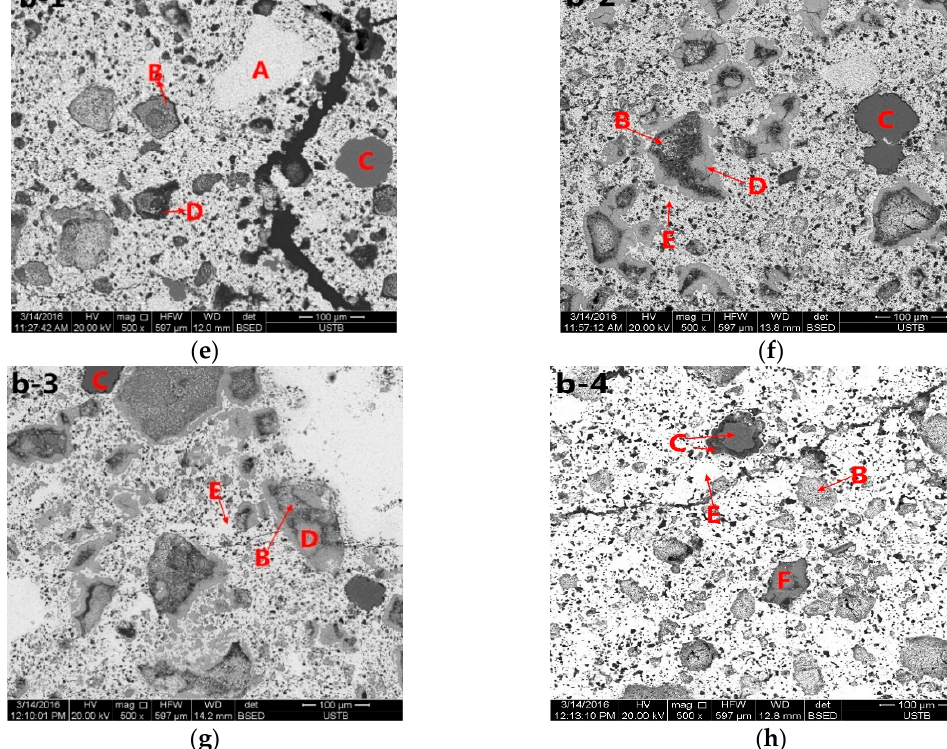
Figure 4. Backscattered electron micrograph of the product of the heat/quench experiment performed at different temperatures for 90 min under air atmosphere, showing Al 2 O 3 , Fe 2 O 3 , CaO, CF, C 2 F, C 2 A, and CFA. ( a – d ), a1–a4, 5.6%Al 2 O 3 , ( e – h ), b1–b4, 1.4% Al 2 O 3 , 1—900 °C, 2—1000 °C, 3—1100 °C, 4—1200 °C, A—Fe 2 O 3 , B—CaO, C—Al 2 O 3 , D—C 2 F, E—CF, F—C 2 A, G—CFA).